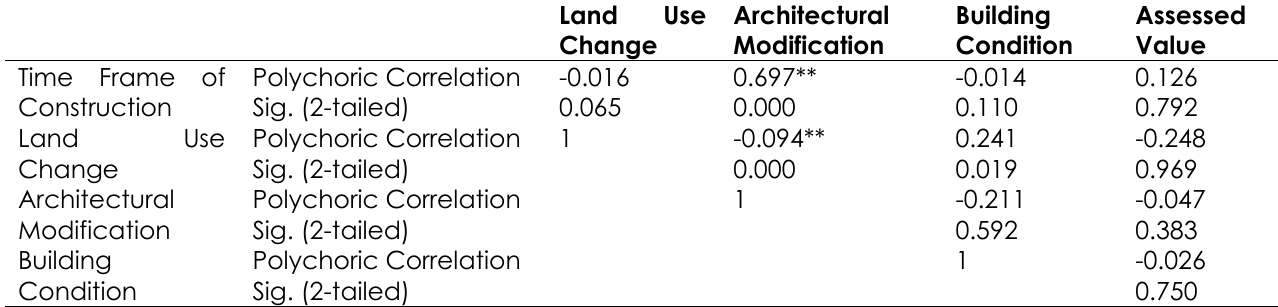
Table 4. Polychoric Correlation Analysis Output.